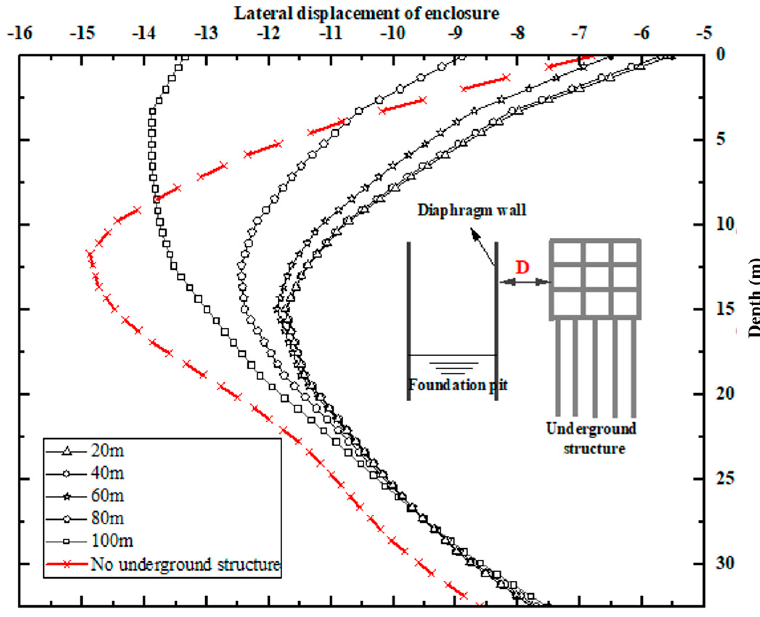
Figure 5. Distribution of lateral displacement of enclosure under different D